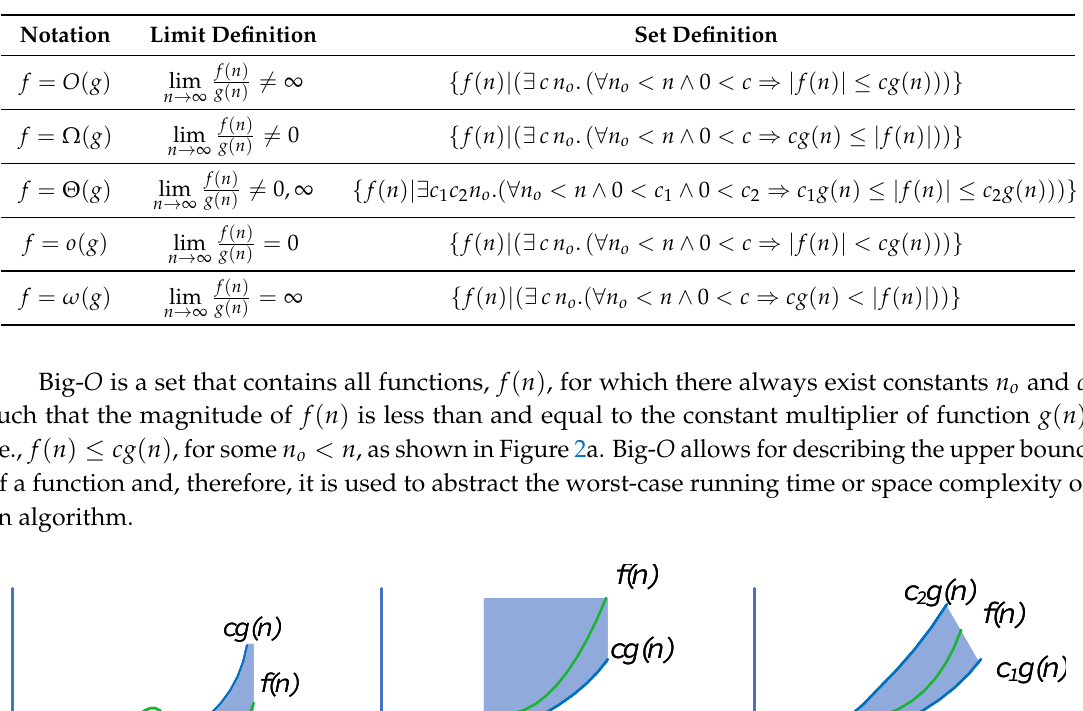
Table 1. Asymptotic Notations.